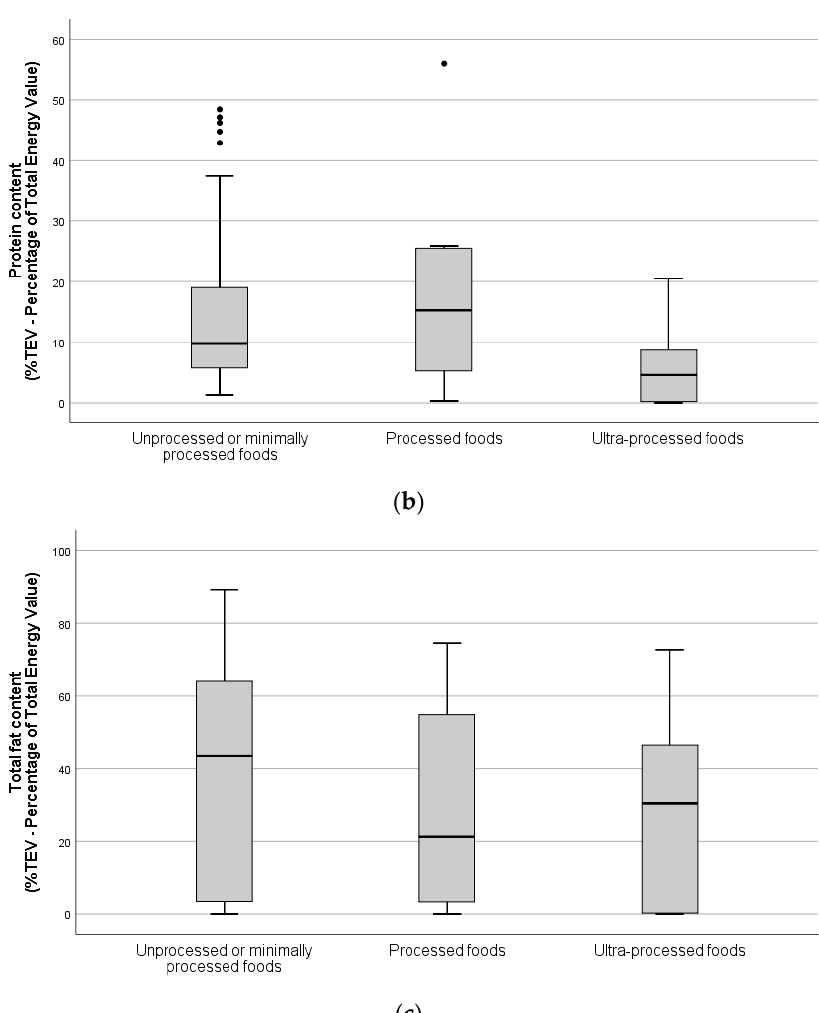
Figure 2. Estimated proportion of total energy value (%TEV) of carbohydrates ( a ), protein ( b ) and total fat ( c ) of the unprocessed/minimally processed, processed, and ultra-processed foods available ( n = 810, vending sites available for interview).